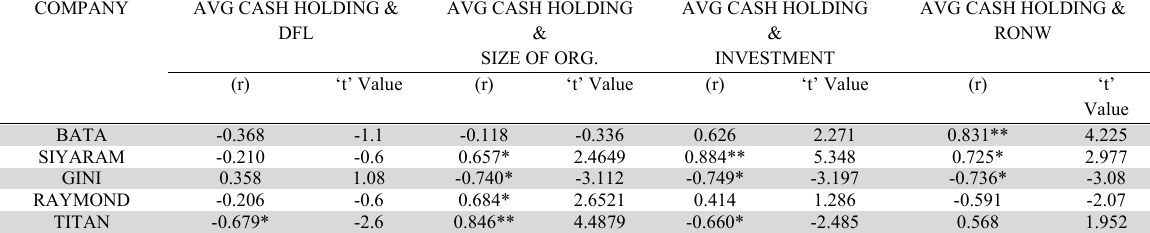
Karl Pearson’s simple correlation analysis between AVG cash holding and DFL, Size of Org., Investment and RONW of the selected companies of retail sector